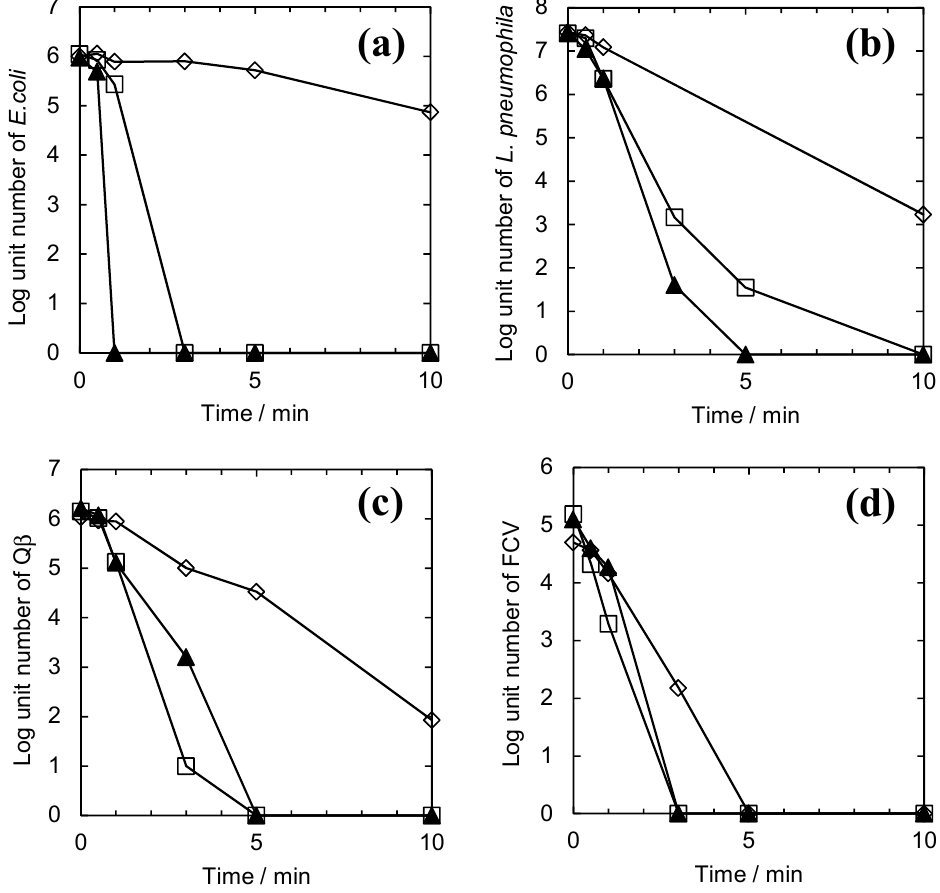
bubbling alone (0.5–1.0 mg/L); 3